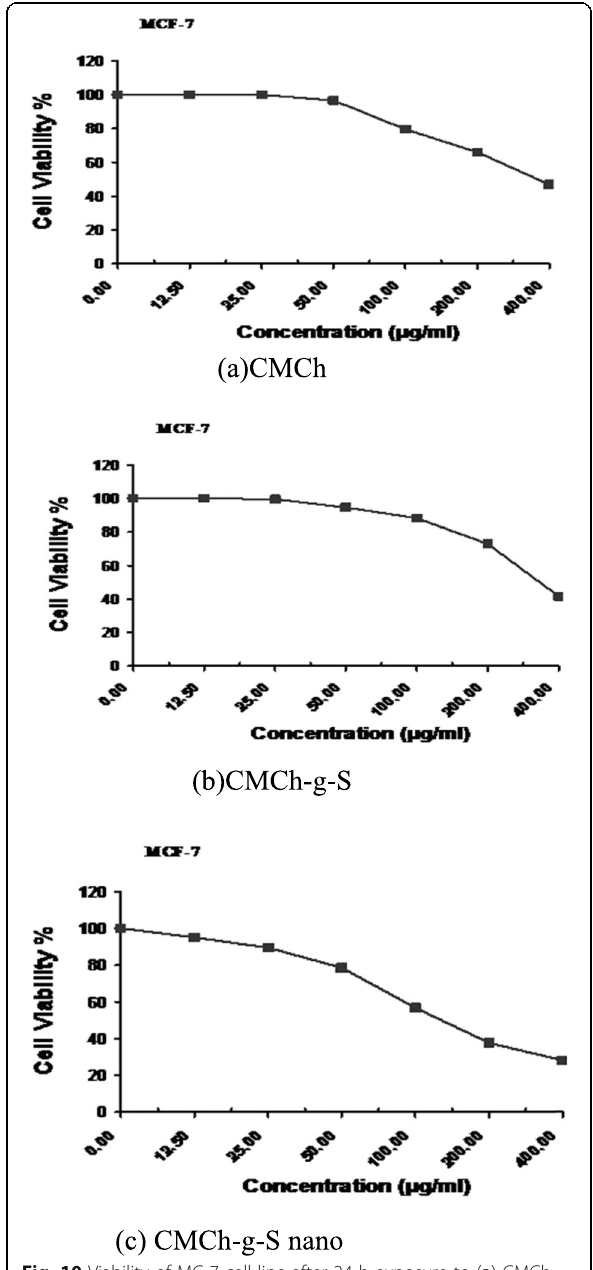
Fig. 10 Viability of MC-7 cell line after 24 h exposure to ( a ) CMCh, ( b ) CMCh-g-S and ( c ) CMCh-g-S nano